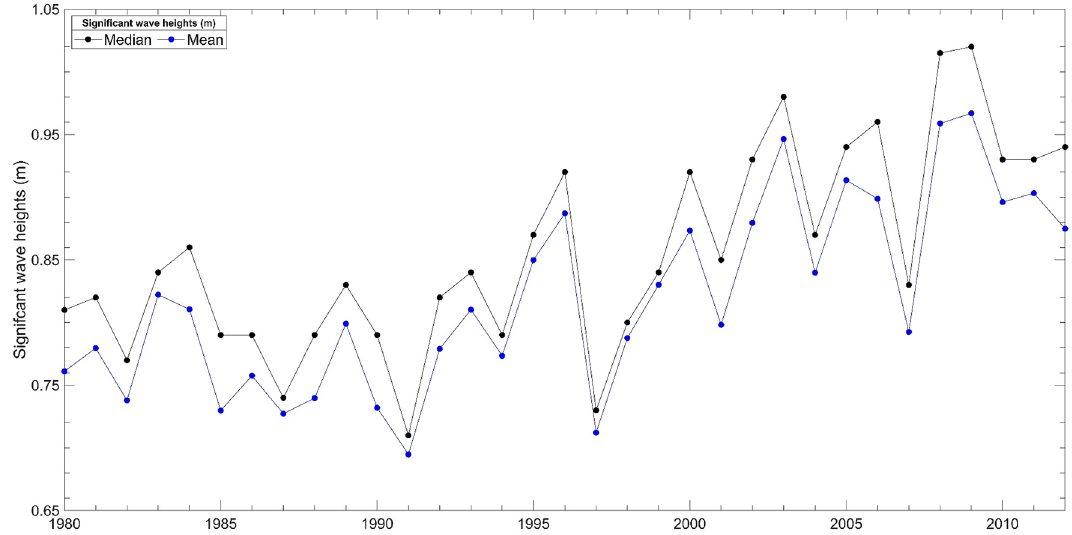
Figure 10. Annual median and mean significant wave height statistics (1980–2012) recorded at the test